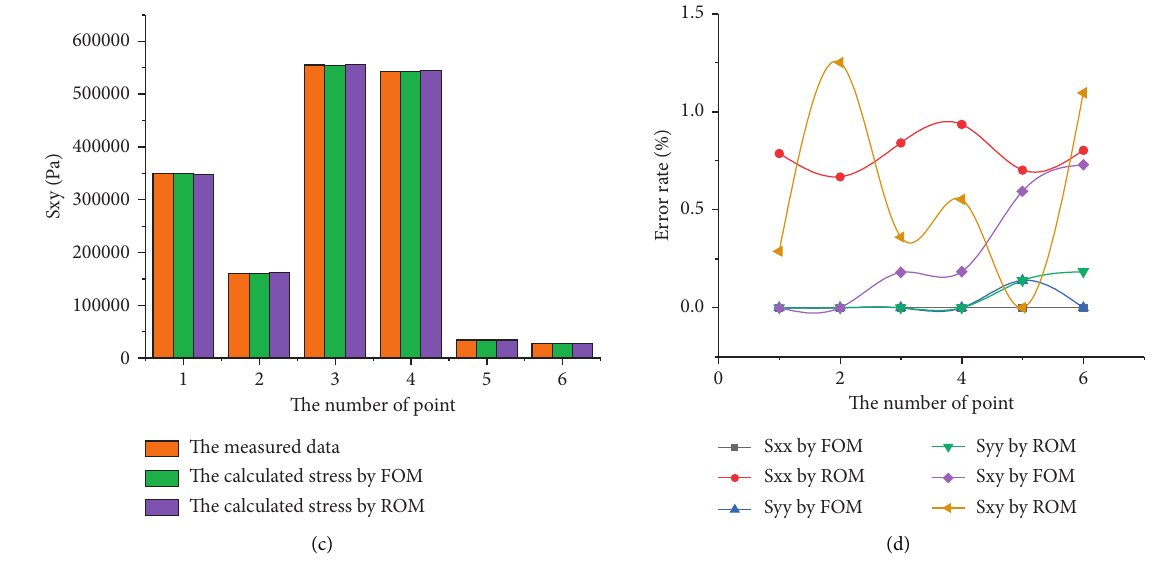
Figure 8: The comparison between the full order model and the reduced order